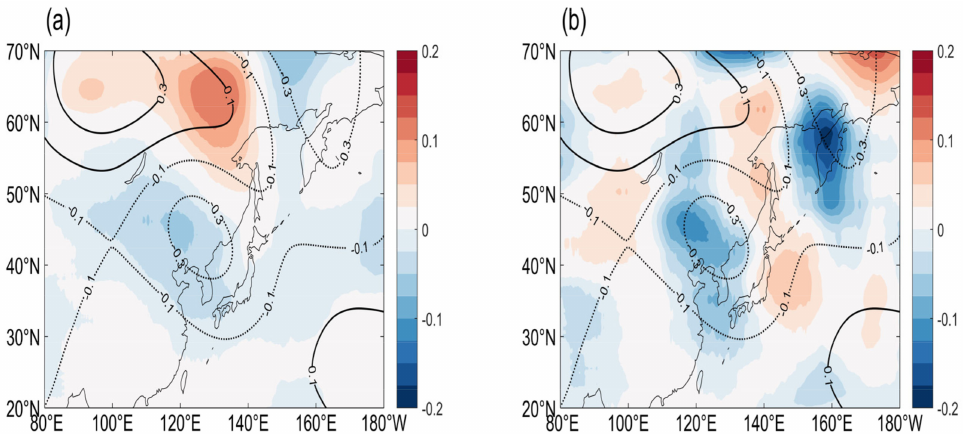
Figure 7. ( a ) The estimated response of Rossby wave-induced 500-hPa geopotential height tendency (shading, unit: gpm day − 1 ) in DJF onto the KEI 2 months earlier, overlapped with the estimated response of 500-hPa geopotential height tendency (contours, unit: gpm day − 1 ). ( b ) is the same as ( a ), but for the transient eddy-induced 500-hPa geopotential height tendency. The data have been smoothed using a 10 ◦ × 10 ◦ spatial average for clearer